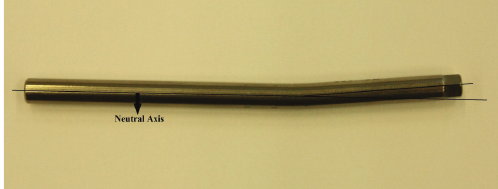
Figure 8: Rod failure in flexion moment test.